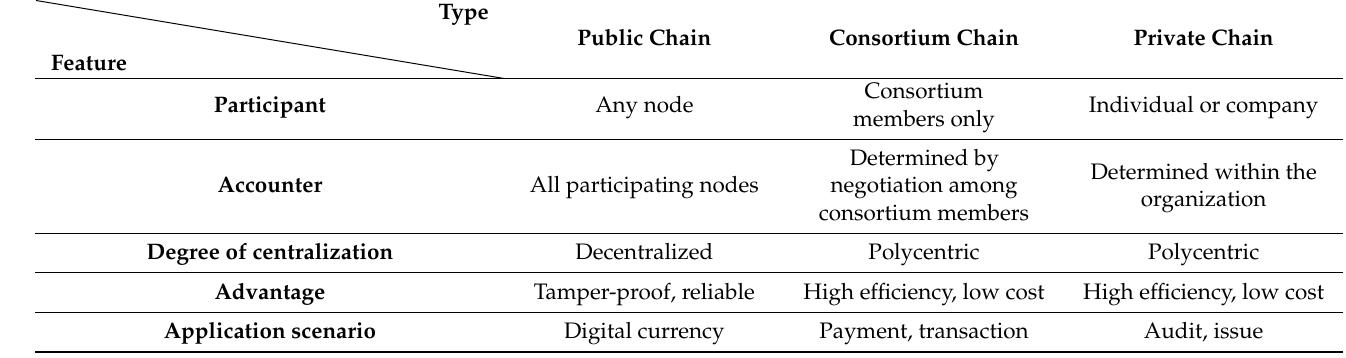
Table 1. Comparison of the blockchain characteristics based on three different